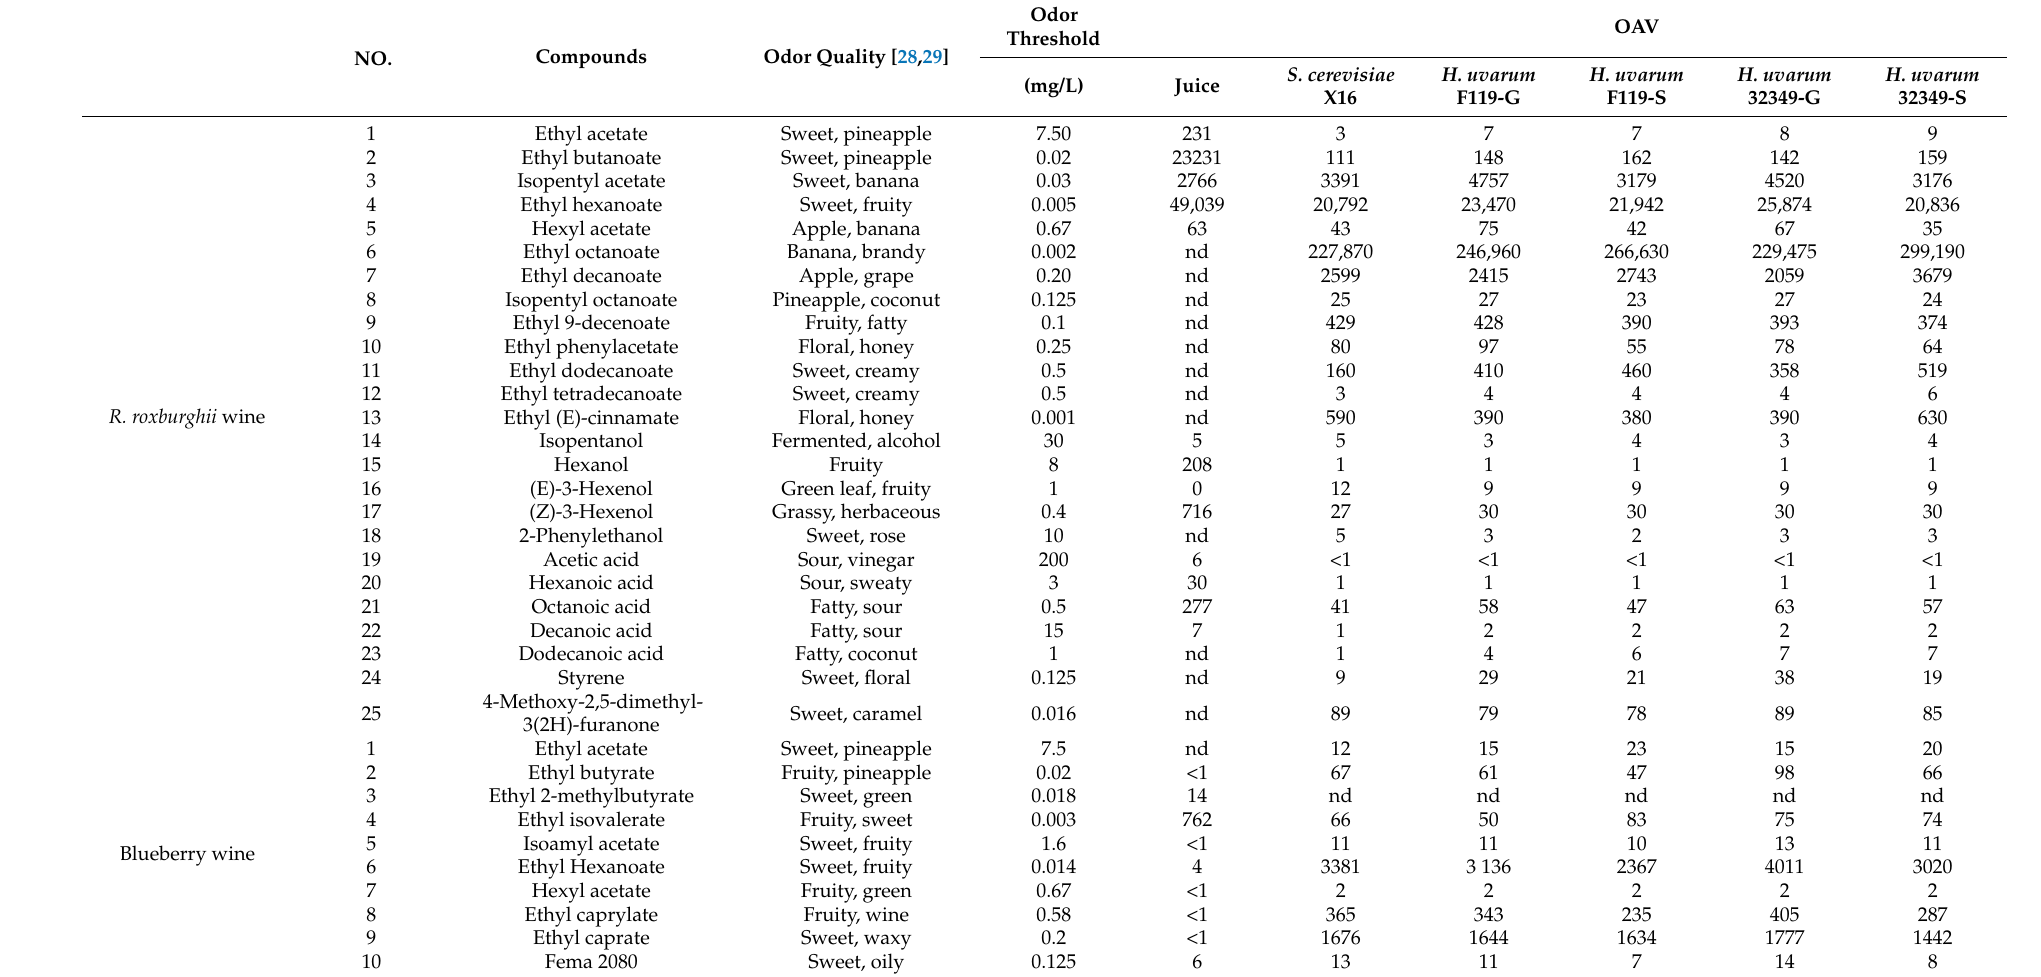
Table 5. Volatile flavor compounds across the different fermentation